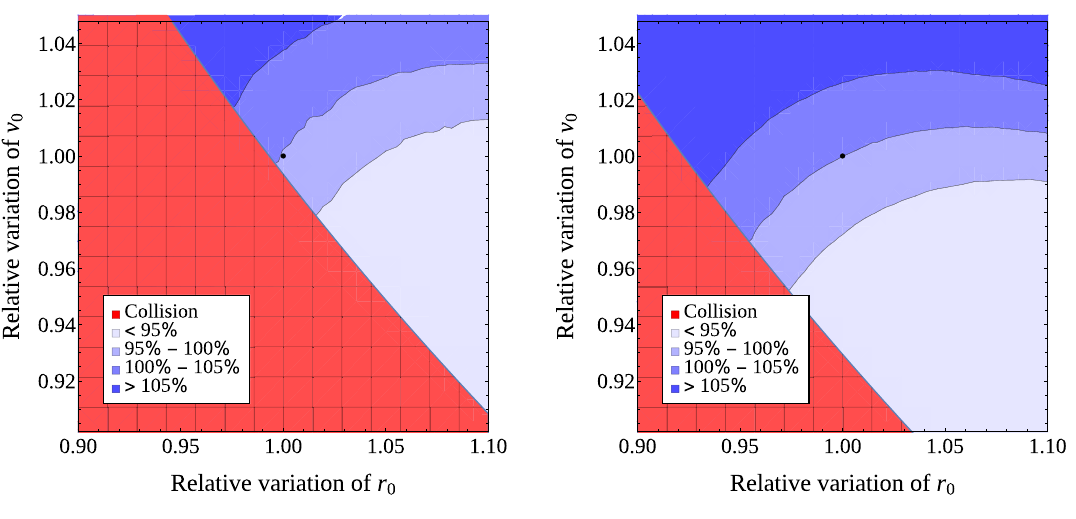
Fig. 18 Impact of variations in the initial conditions on the observ- s − 1 and ˙ θ 0 = 395 . 5 μ rad s − 1 . Variations which will generate collision able defined in Eq. (22) measured over 30 revolutions, for λ = 50 μ m are represented in meshed red. We observe that the second set of initial and α = 0 . 03. Left panel: r 0 = 111 . 8 μ m, ˙ r 0 = 30 . 6 nm s − 1 and conditions is more “robust” against uncertainties in their ˙ θ = 491 . 1 μ rad s − 1 ; Right panel: r = 128 . 8 μ m, ˙ r = 22 . 6 nm 0 0 0